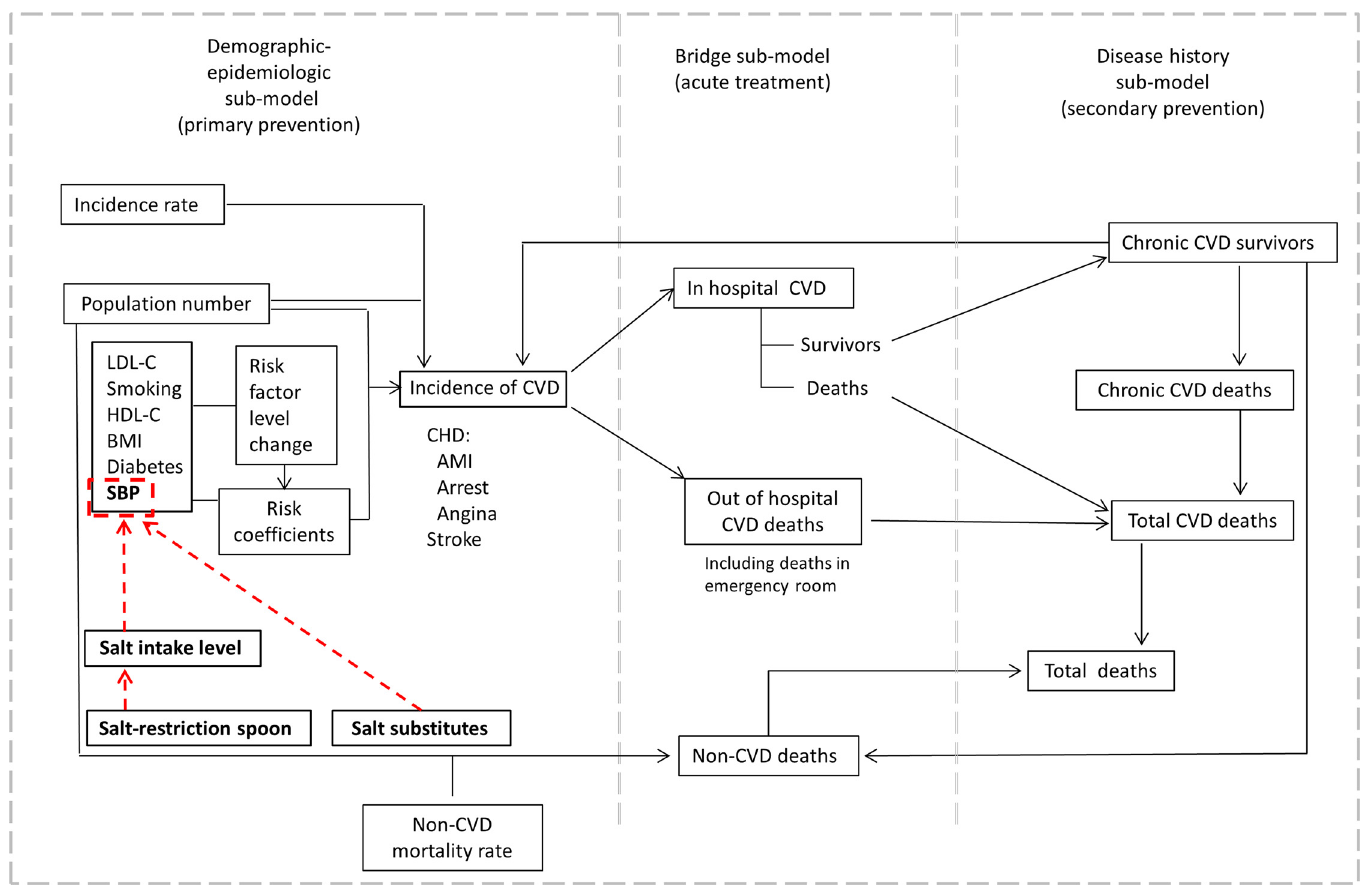
Fig 1. Conceptual diagram of the effect of salt reduction on the CVD prevention. AMI, acute myocardial infarction; BMI, body mass index; CHD, coronary heart disease; CVD, cardiovascular disease; HDL-C, high-density lipoprotein cholesterol; LDL-C, low density lipoprotein cholesterol; SBP, systolic blood